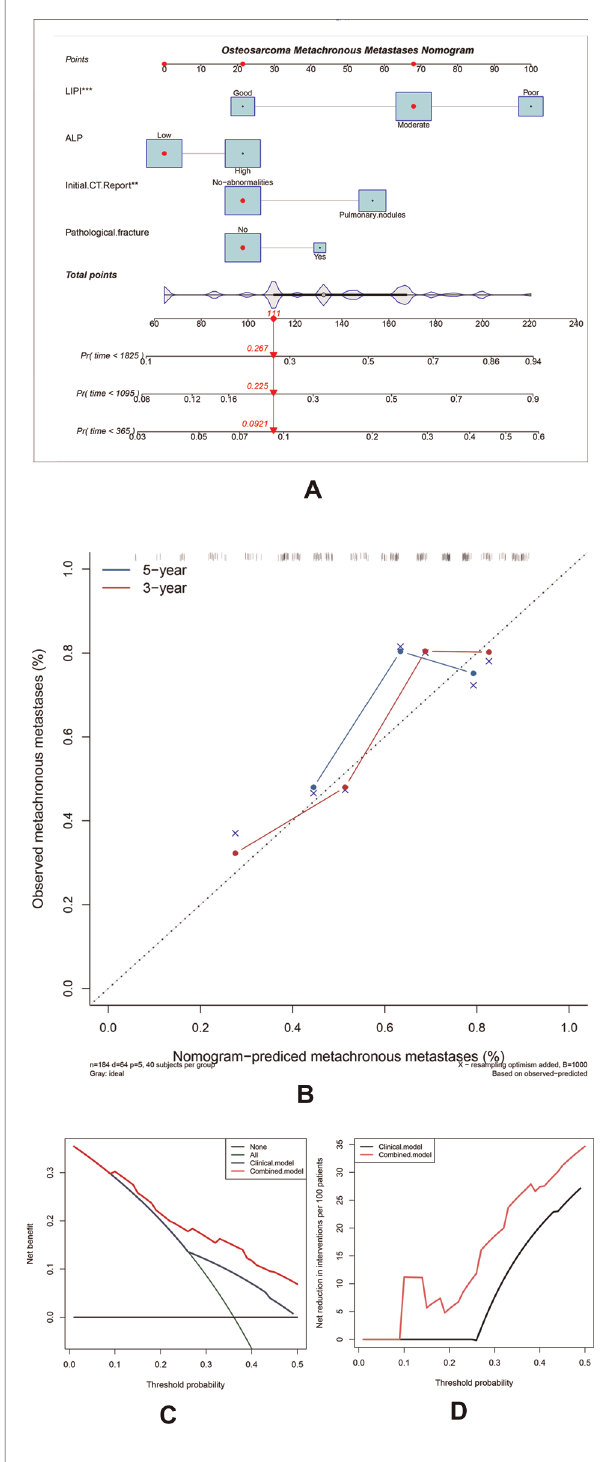
FIGURE 4 | Construction and validation of the osteosarcoma metachronous metastases nomogram. ( A ) The nomogram was constructed by combining the LIPI, ALP, initial CT report, and pathological fracture, and the sum of the scores for each covariate was the nomogram total score. ( B – D ) This nomogram was validated by the calibration curve, decision curve analysis, and clinical impact